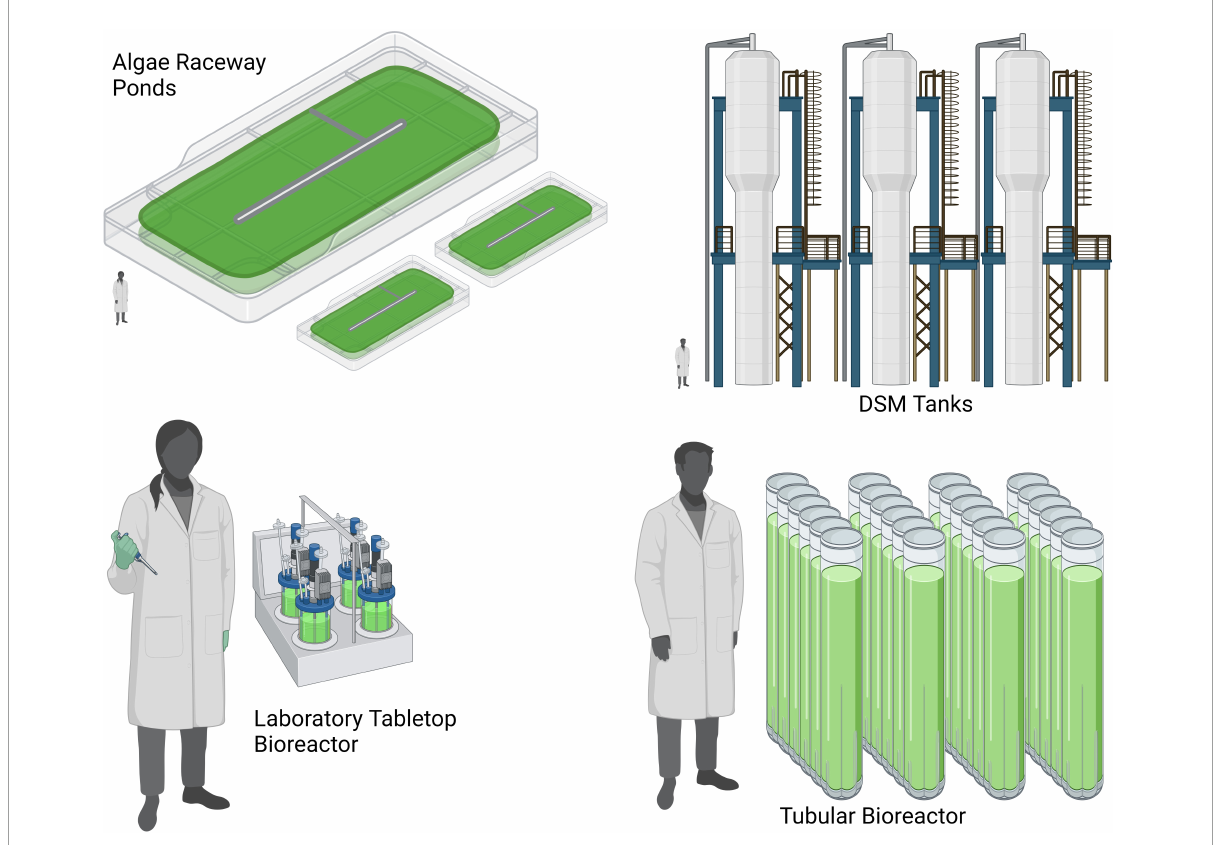
FIGURE2 Visual comparison of various algae cultivation methods (Created with